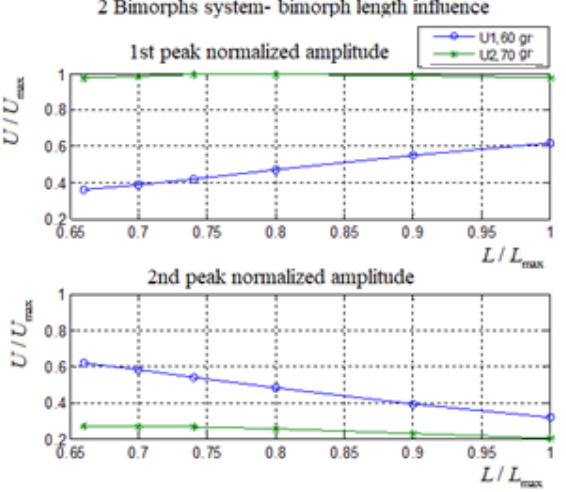
Figure A7. The influence of the normalized bimorph length on the normalized amplitude at the first and second peaks—two bimorphs interconnected by a spring case.